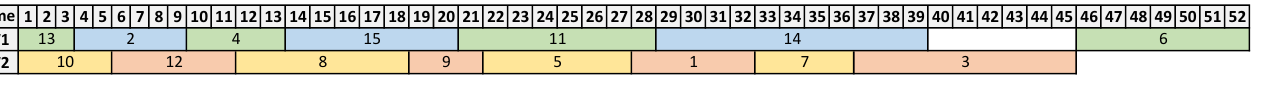
Figure 12. Scenario 2: Task scheduling resulting from SPT